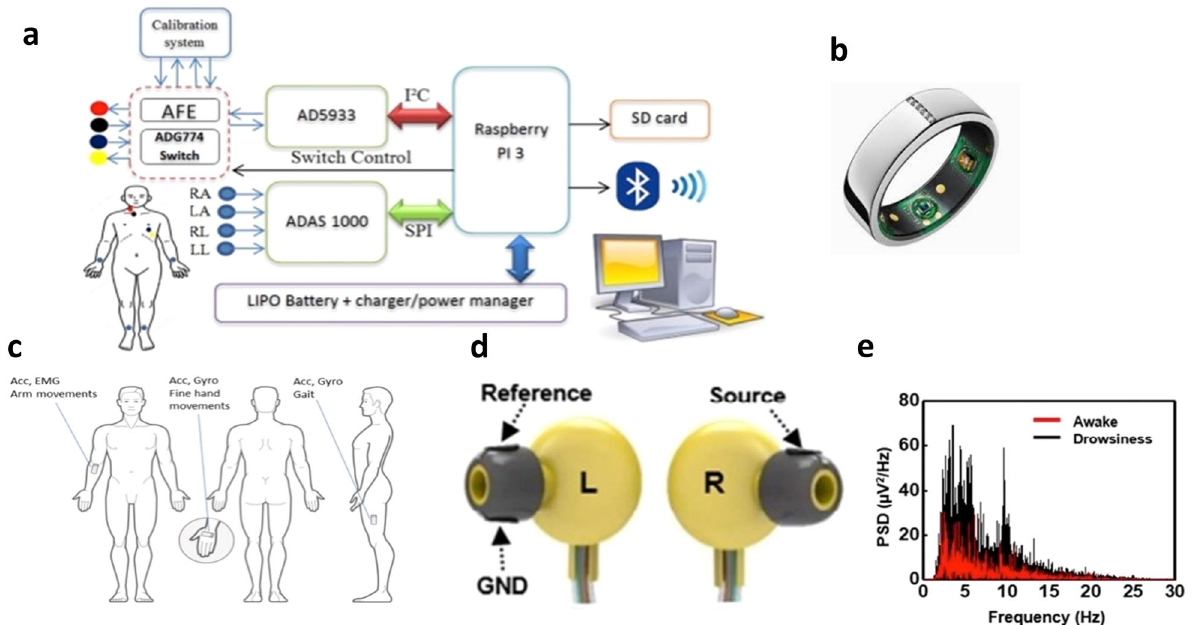
Fig. 4 Other competitive skin-based HWDs. a Schematic of the Heart Failure Prediction System. Reproduced with permission from Ha fi d et al. 48 Copyright © IEEE Journal Of Biomedical and Health Informatics,2018. b Oura Ring with miniaturized sensors on it to diagnose different illnesses. Reproduced with permission 50 Copyright © Oura Ring, 2020. c Position of sensors for the detection of bradykinesia and tremor features of PD. Reproduced with permission from Lonini et al. 71 Copyright © npj Digital Medicine, 2018. d Earphones for the portable acquisition of EEG with reference and ground electrodes on left earphone and source electrode on right earphone. e Power Spectral Density (PSD) for the differentiation of the state of drowsiness and awake state using EEG from HWD as illustrated in d . Reproduced with permission from Lee et al. 78 Copyright © ACS Applied Materials and Interfaces,